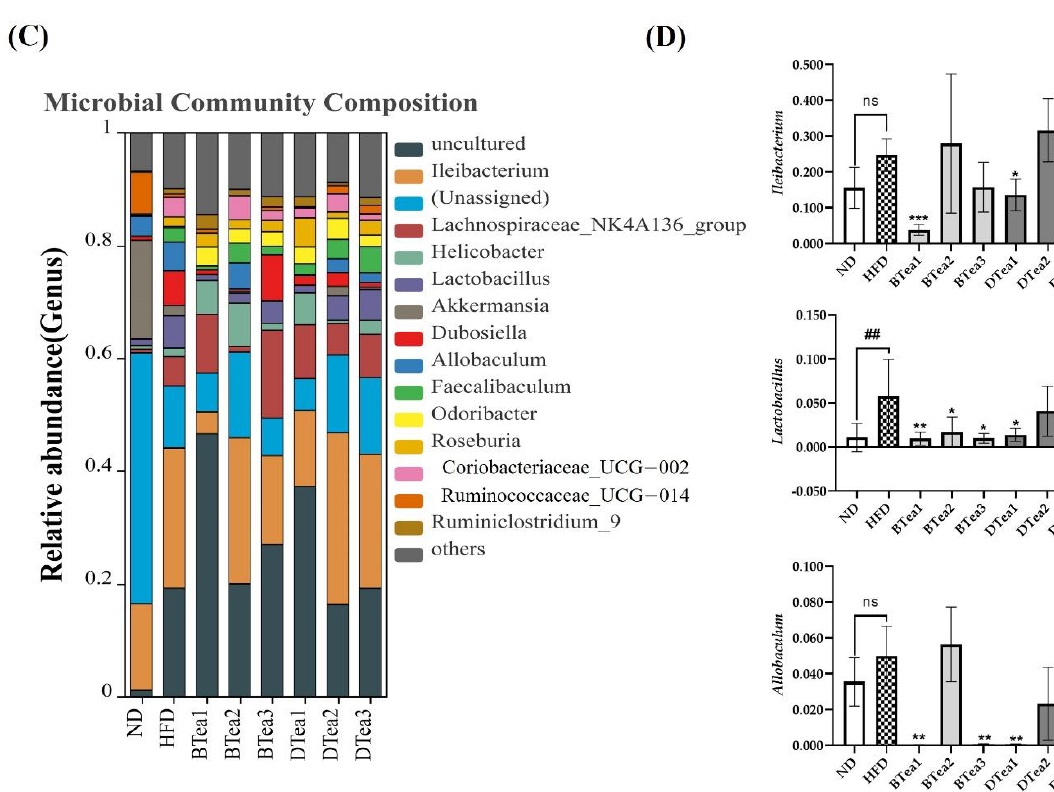
Figure 8. The effects of different black and dark teas on the gut microbiota composition at the phylum and genus levels. ( A ) Relative abundance of the gut microbial profile at the phylum level among all groups; ( B ) relative abundance of Firmicutes , Bacteroidetes , the ratio of Firmicutes and Bacteroidetes , Proteobacteria , Actinobacteria and Verrucomicrobia among all groups; ( C ) relative abundance of the gut microbial profile at the genus level among all groups; ( D ) relative abundance of Ileibacterium , Lachnospiraceae _NK4A136_group, Helicobacter , Lactobacillus , Akkermansia , Dubosiella , Allobaculum , Odoribacter and Roseburia among all groups. The results are expressed as mean ± standard deviation. ND, the control group (normal diet group); HFD, the model group (high-fat diet group); BTea1, selenium-enriched black tea; BTea2, Dianhong tea; BTea3, Yingde black tea; DTea1, Fu brick tea; DTea2, Liupao Tea; DTea3, selenium-enriched dark tea. # p < 0.05, ## p < 0.01, ### p < 0.001, the HFD group compared with the ND group; * p < 0.05, ** p < 0.01, *** p < 0.001, the tea extract supplementary groups compared with the HFD group. ns, no statistically significant differences ( p > 0.05) between the model group and the control